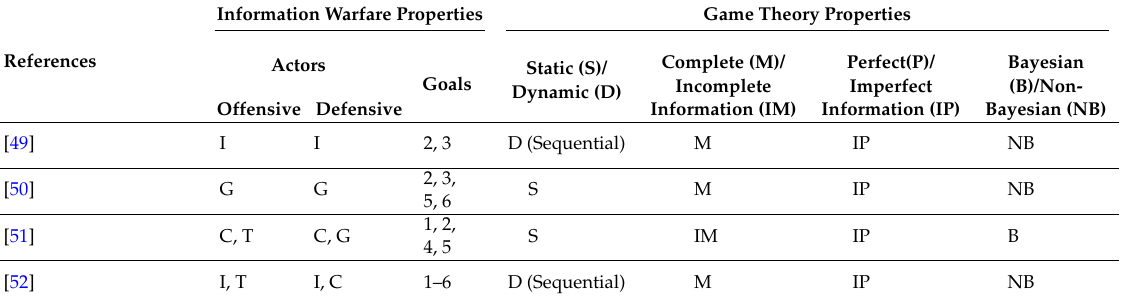
Table 4. List of Military Deception Games.